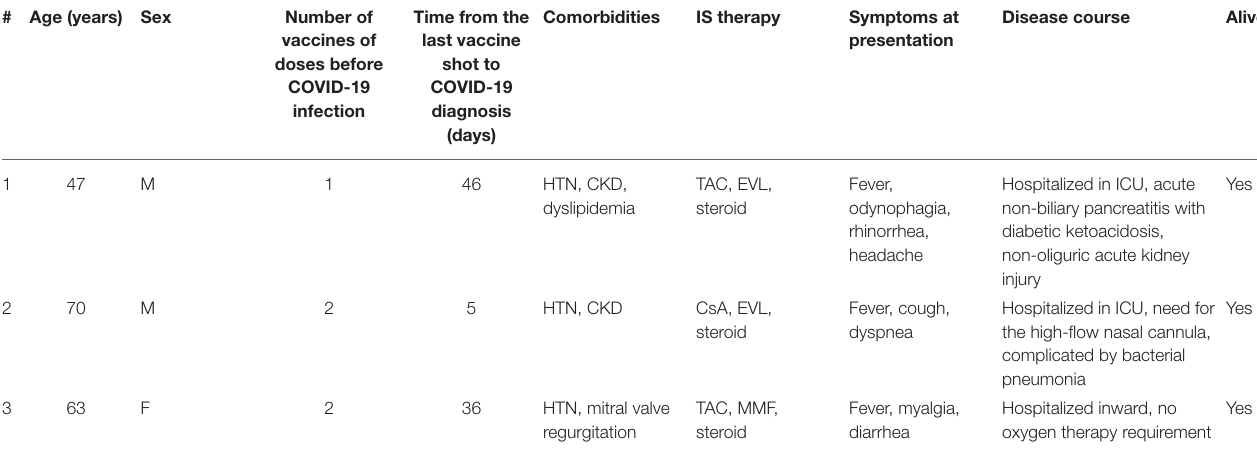
TABLE 2 | Clinical characteristics and disease course of heart transplant recipients with COVID-19 infection following vaccination. # Age (years) Sex